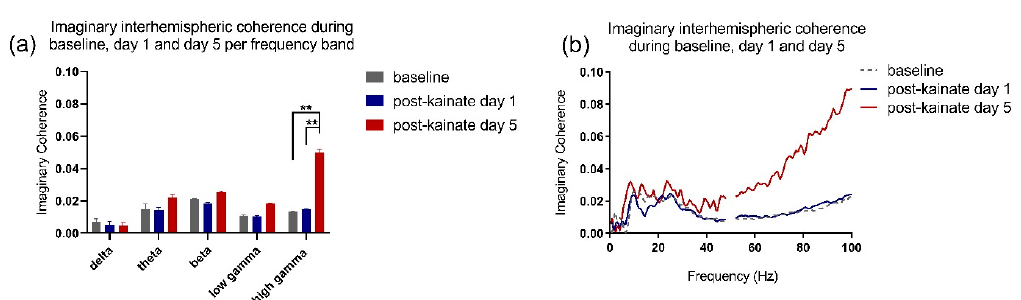
Figure 2. Average interhemispheric coherence between primary motor cortices before (baseline day) and after 5 days of repeated vermis cerebellar kainate administration across different frequency spectral bands. ( a ) Delta band (0.5–3.5 Hz). ( b ) Theta band (4–12.5 Hz). ( c ) Beta band (13–30 Hz). ( d ) Low ‐ gamma band (30.5–48 Hz). ( e ) High ‐ gamma band (52–100 Hz) frequencies in baseline day and kainate administration day. ( f ) For each frequency band, the coherences are expressed as average ± the standard error of the mean (* for p < 0.05 and ** for p < 0.01, day of kainate application versus baseline day; statistical tests detailed in Table 1).